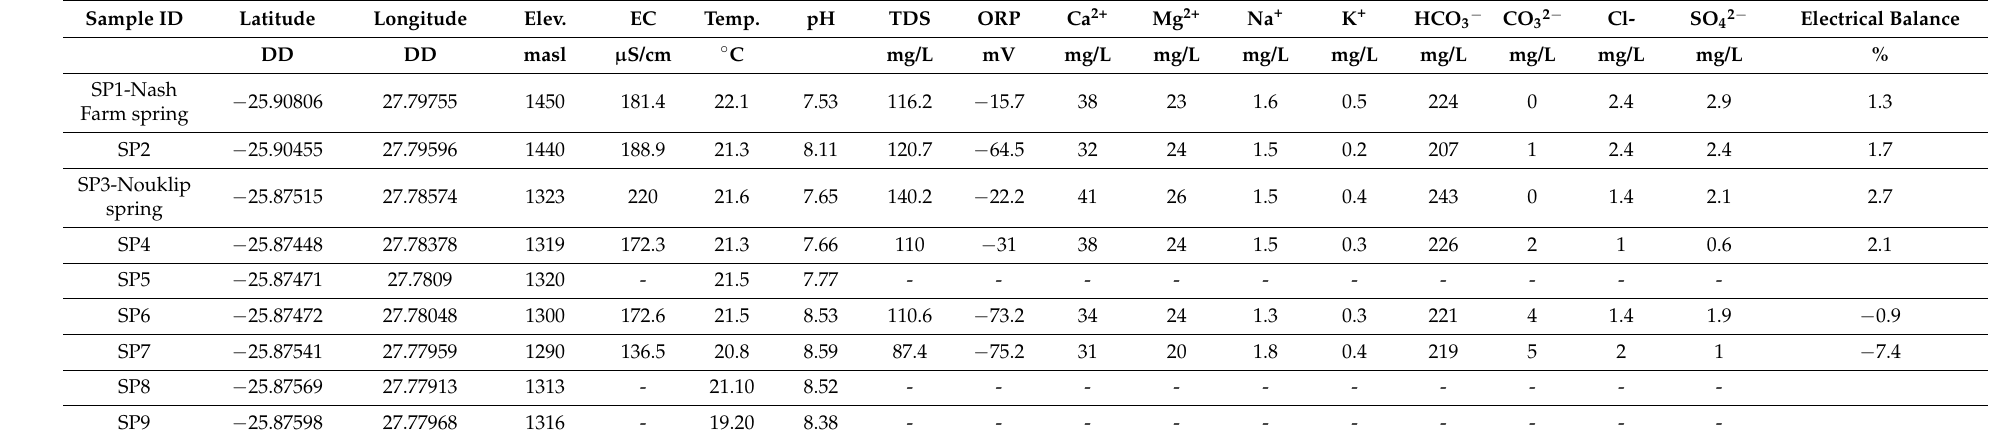
Table 5. Hydrochemical data for the Malmani Dolomite